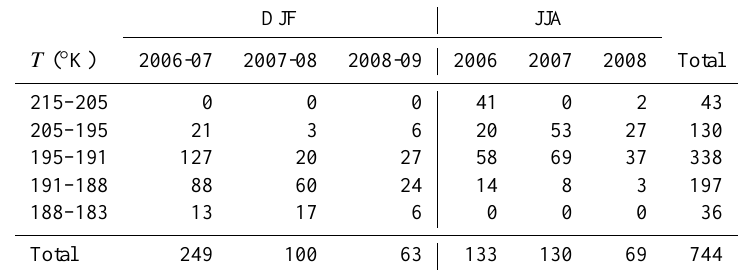
Table 3. Number of C1 SVC with respect to temperature. Most SVC are located in 195–191K.